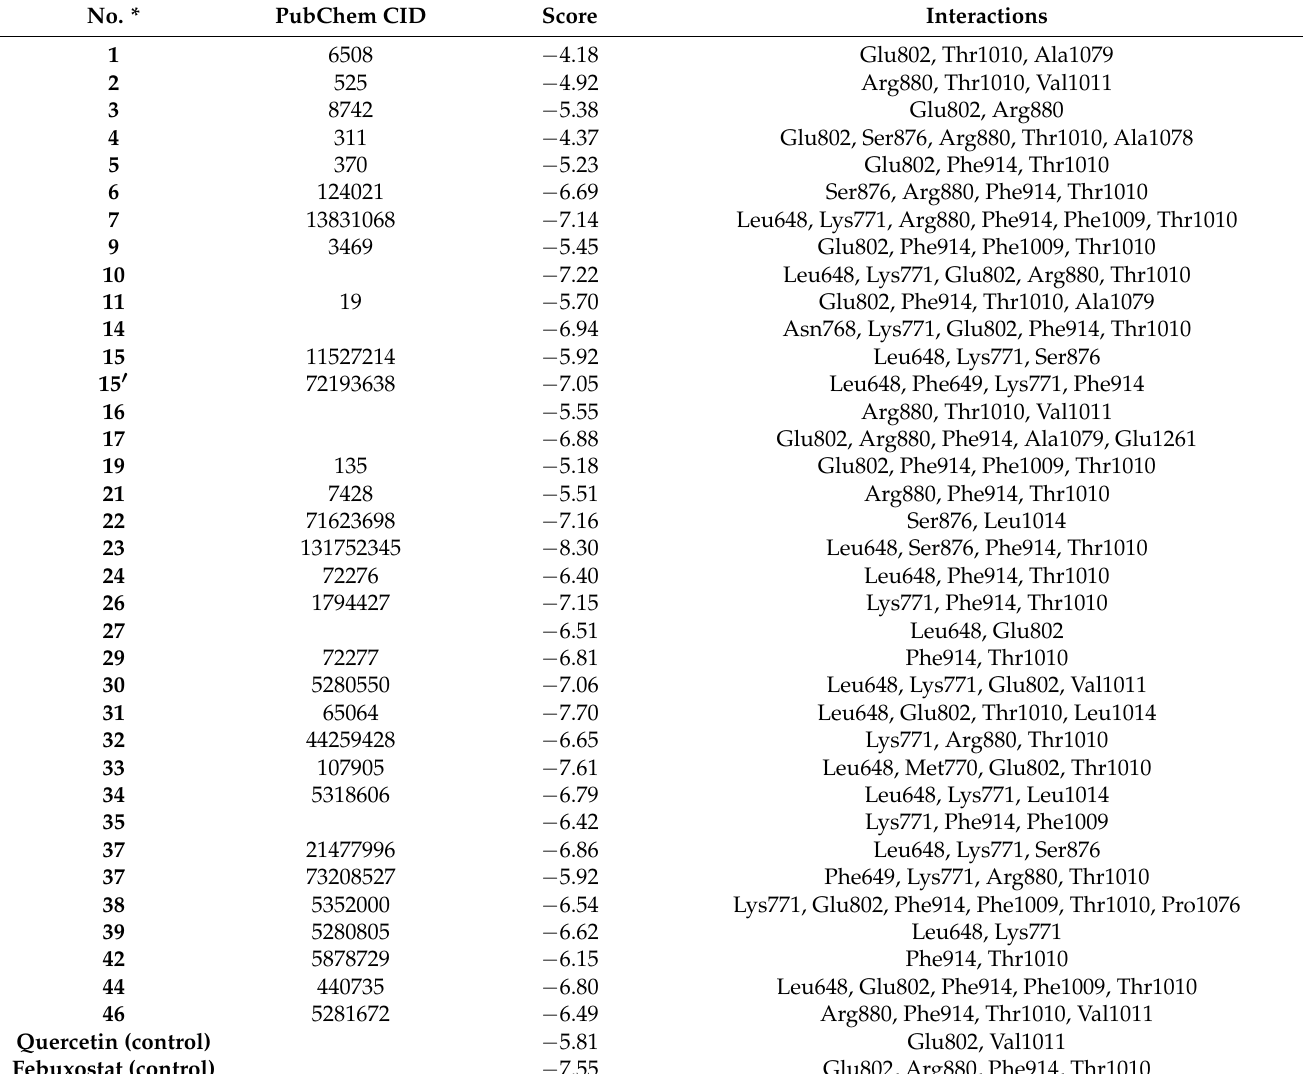
Table 2. Docking scoring functions (kcal/mol) of E. divinorum metabolites with xanthine